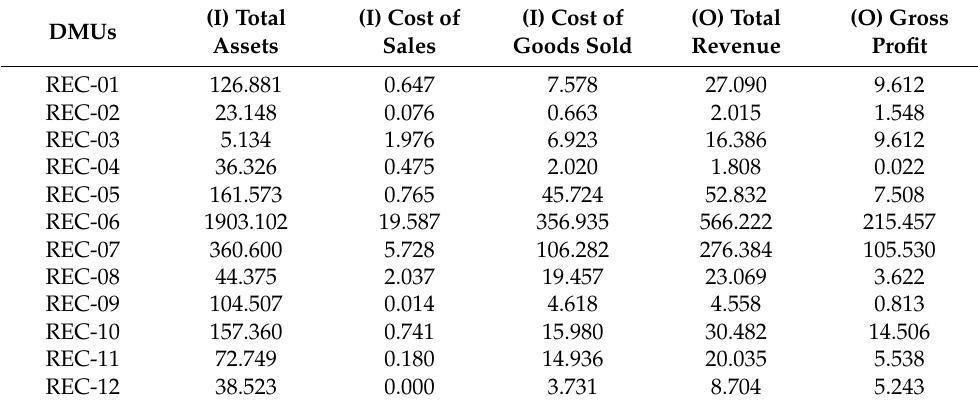
Table A6. The predictive data of the year 2020, (unit: million USD).